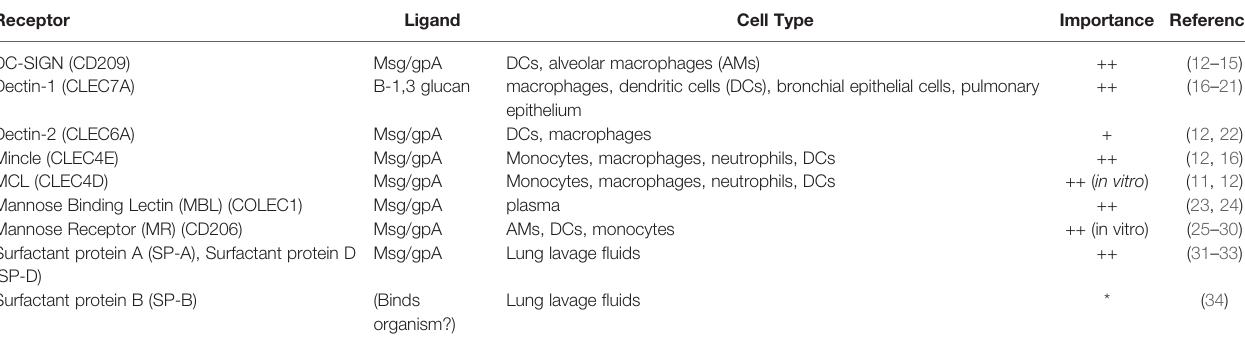
TABLE 1 | List of host immune receptors, their Pneumocystis ligands, presence in relevant cell types in PCP, and importance in host/ Pneumocystis interactions or response.